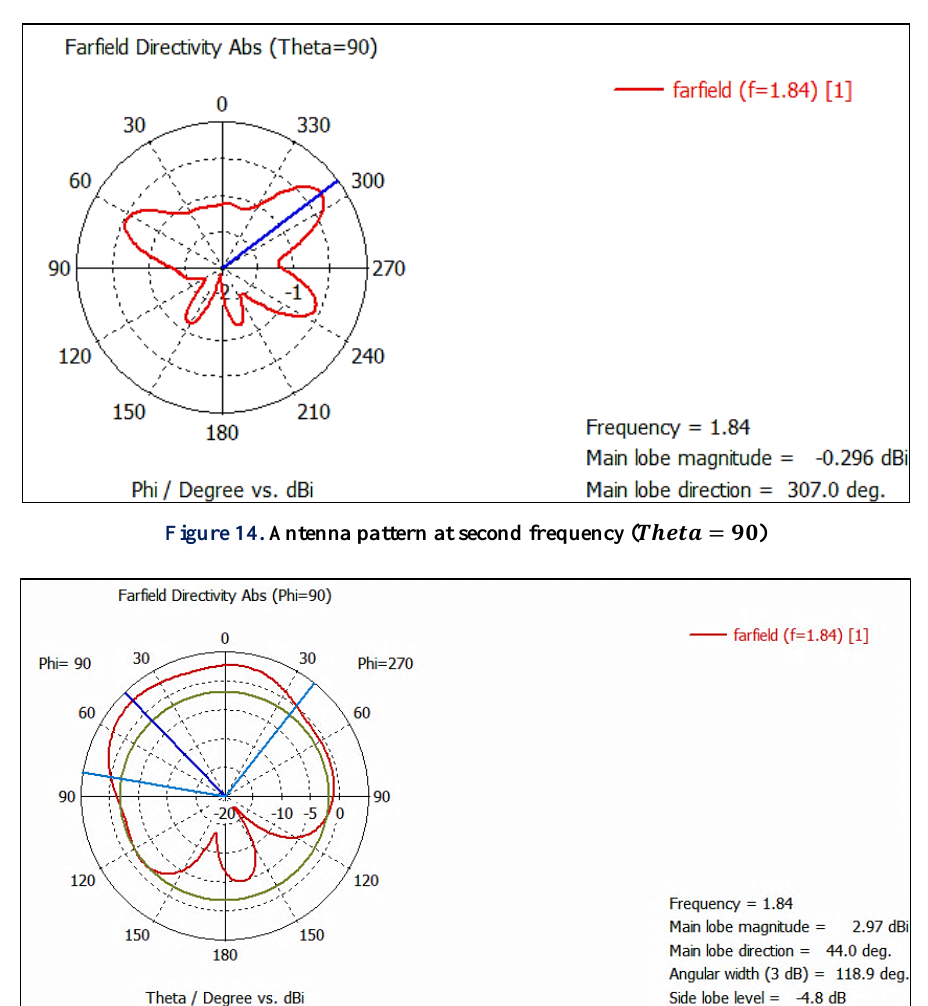
Figure 15. Antenna pattern at second frequency ( 𝑷𝒉𝒊 = 𝟗𝟎